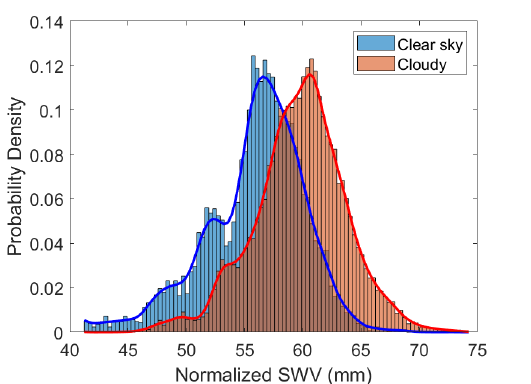
Figure 12. Probability density of normalized SWV associated with clear sky and cloudy conditions in the months of April and May